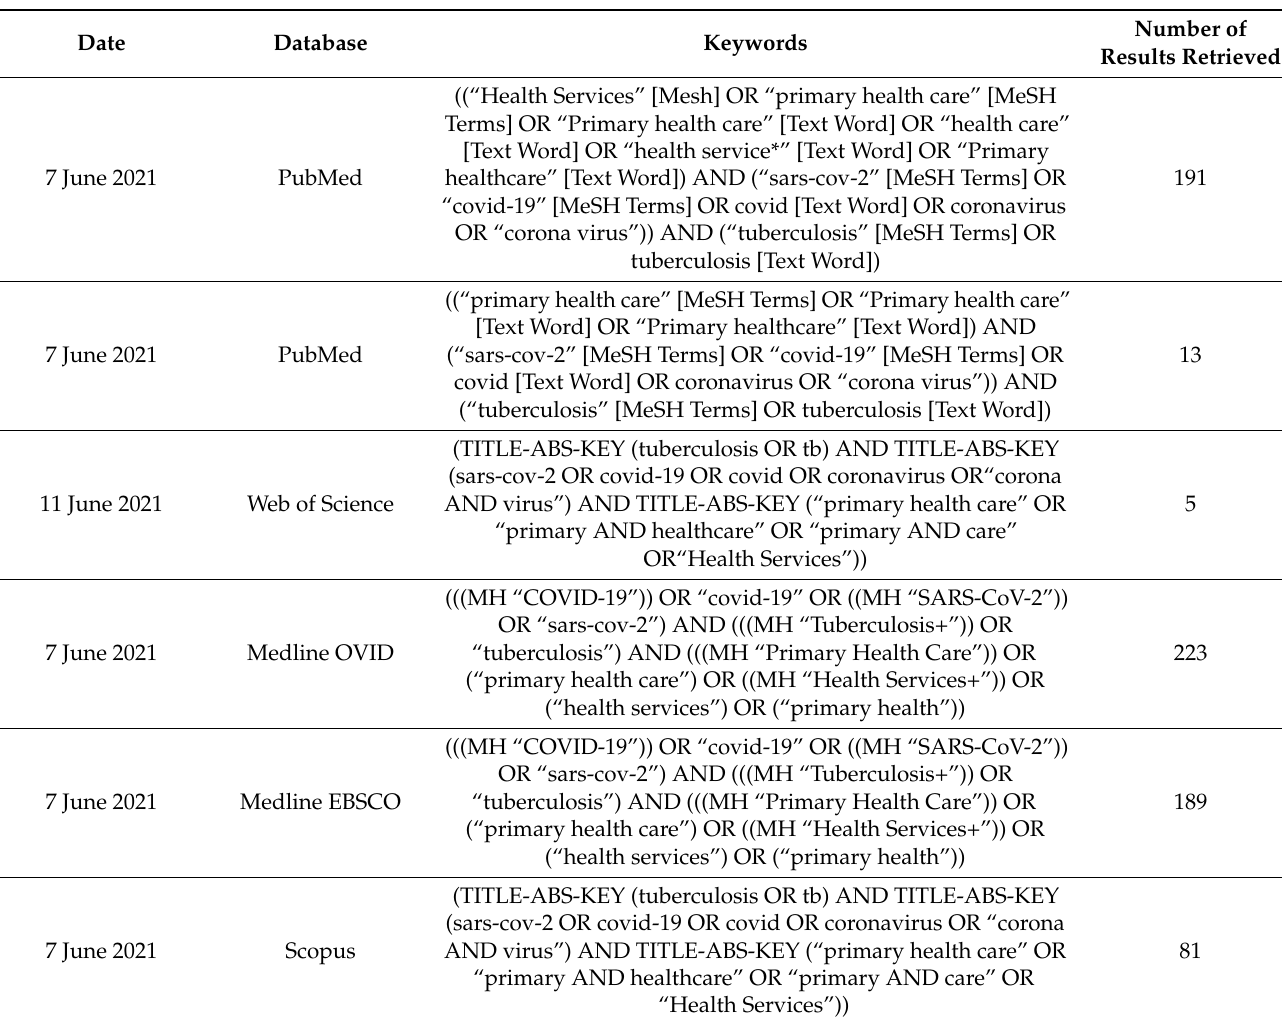
Table 2. Results of the database